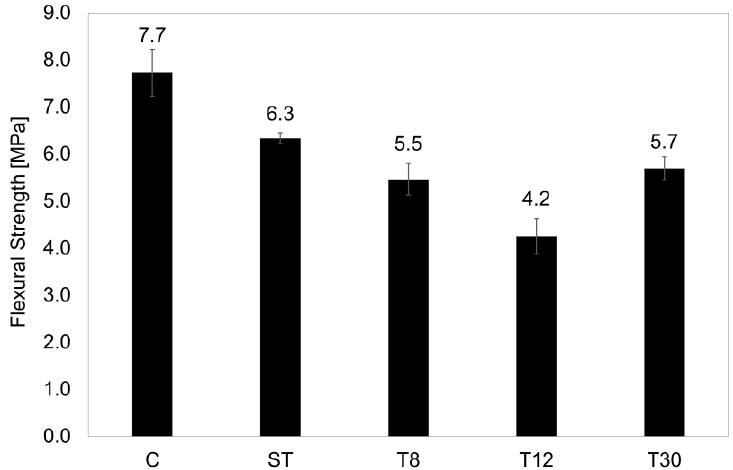
Figure 3. Flexural strength of mortar samples at 28 days of curing. The error bars represent the standard deviation.